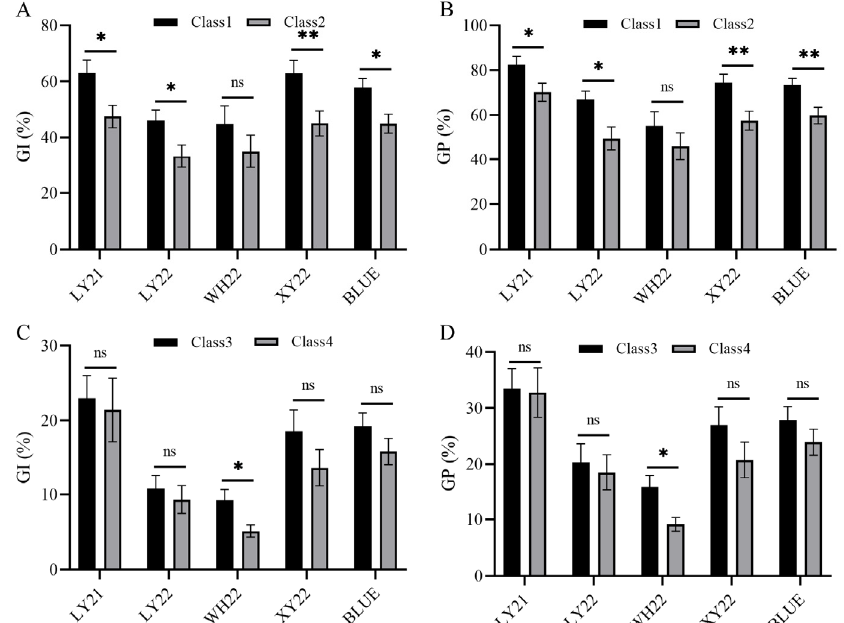
Figure 2. Effect of Qdor.hzau ‐ 3D.2 in the absence or presence of grain color QTLs on GI ( A , C ) and GP ( B , D ) for all environments. Class 1 and 2 represented without and with the loci Qdor.hzau-3D.2 in the absence of grain color QTLs, respectively; Class 3 and 4 represented without and with the loci Qdor.hzau-3D.2 in the presence of grain color QTLs, respectively; * p < 0.05; ** p < 0.01; ns, nonsignif ‐ icant.